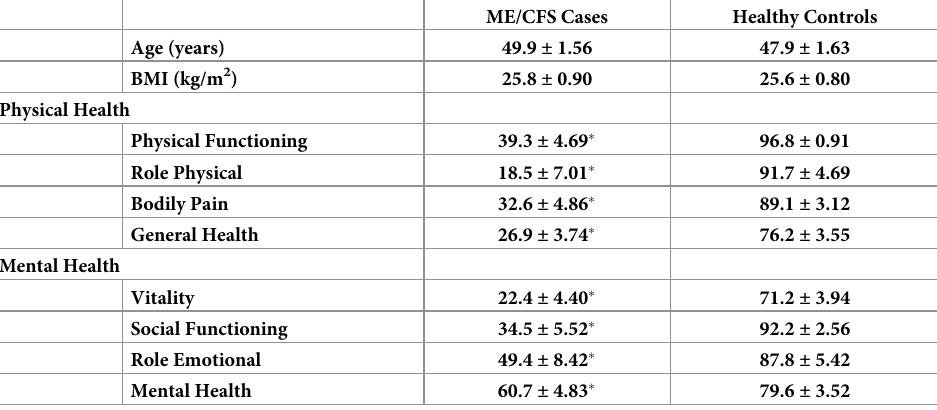
Table 1. Demographic information and SF-36 results for all ME/CFS cases (n = 33) and controls (n = 31) that par- ticipated in DNA methylation analysis and validation. (cid:3) —p < 0.05, Student’s t-test, ME/CFS cases versus controls subjects. Data are shown as mean ± standard error of